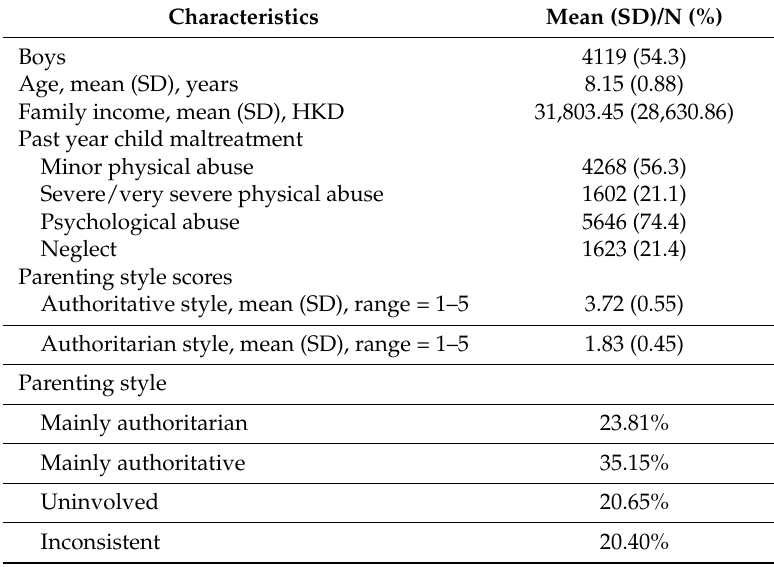
Table 1. Participant characteristics ( n =